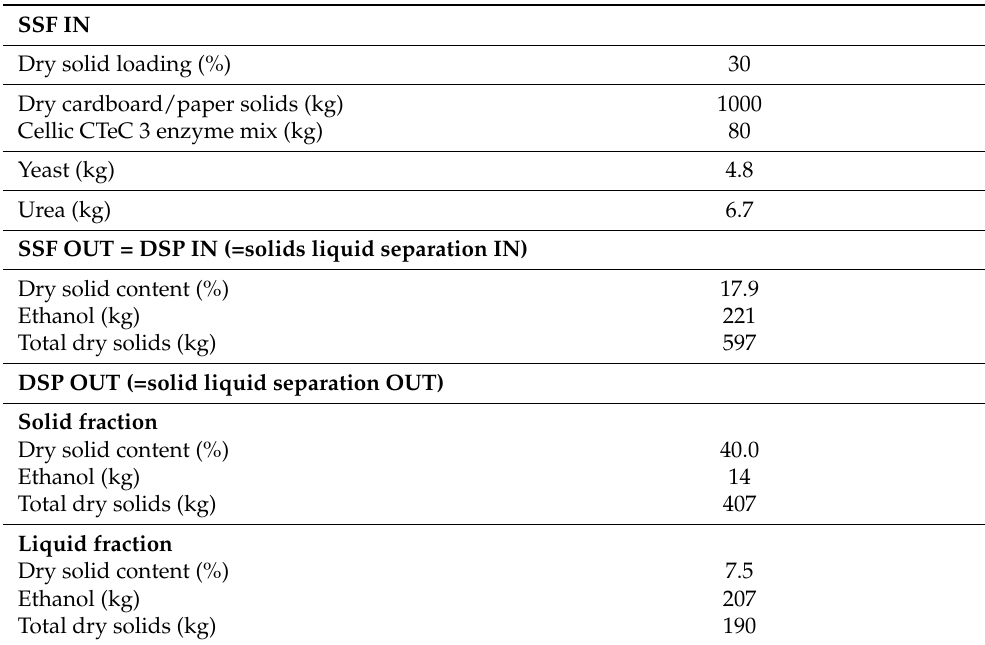
Table 5. Mass balance of the demonstrated SSF process (2 m 3 scale) with pretreated cardboard and paper